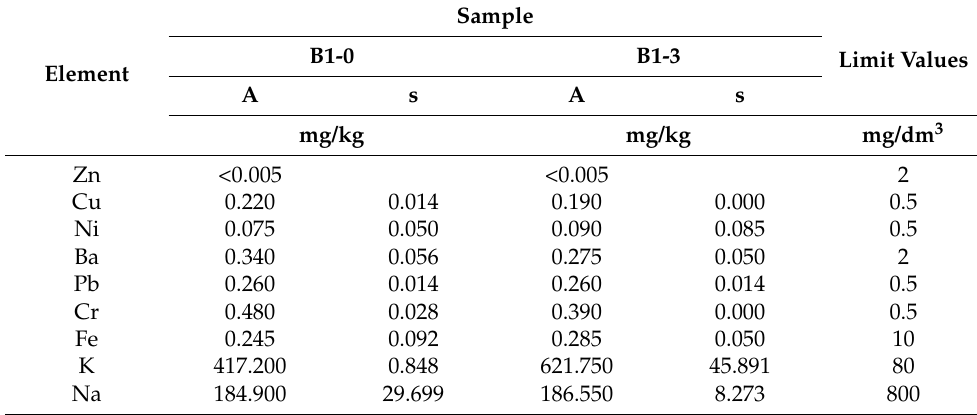
Table 5. Results of the analysis of ion leaching from concrete samples.